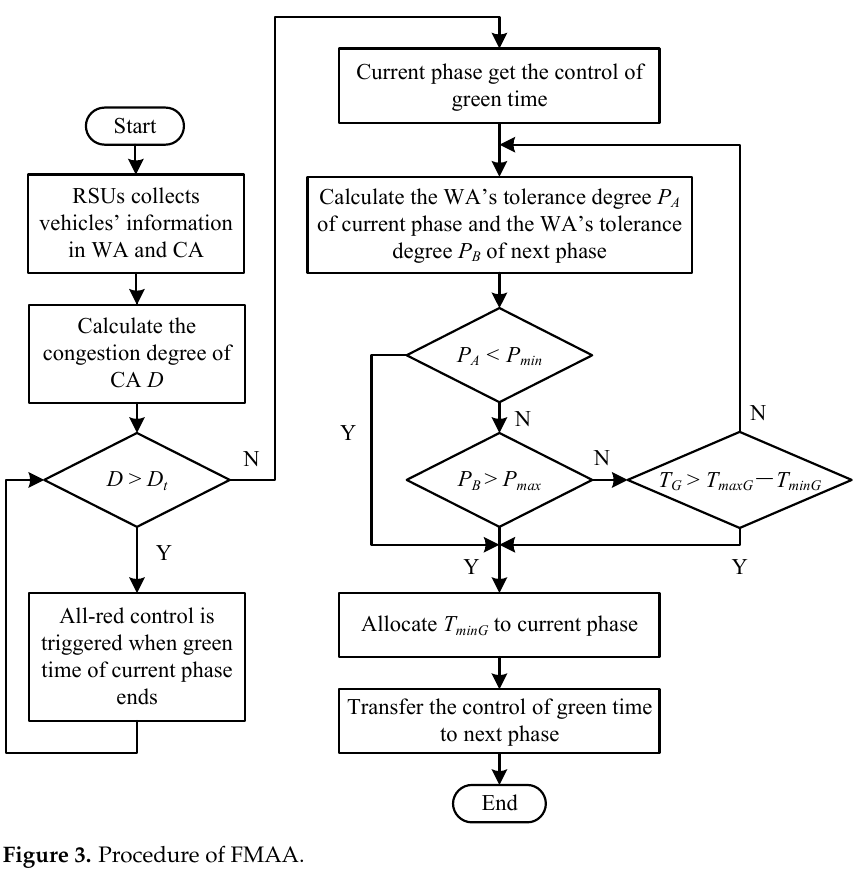
Figure 3. Procedure of